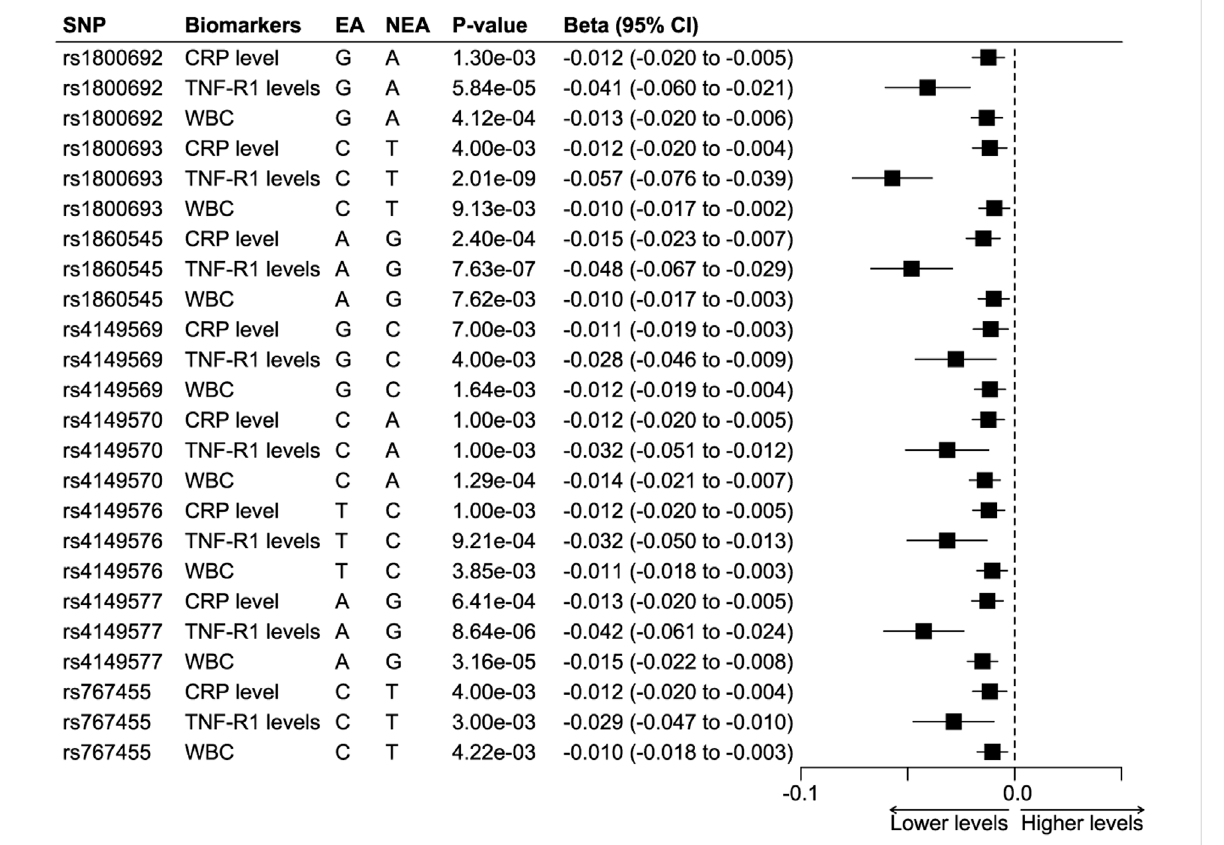
FIGURE 1 The association estimates of the eight SNPs with in fl ammatory biomarkers. Abbreviations: CRP, C-reactive protein. EA, effect allele. NEA, non- effectallele. SNP,singlenucleotidepolymorphism.TNFR1,tumornecrosisfactorreceptor1.WBC, whitebloodcount.Footnote:Theresultsshowed that all the SNPs were associated with statistically signi fi cant lower levels of TNFR1, CRP, and